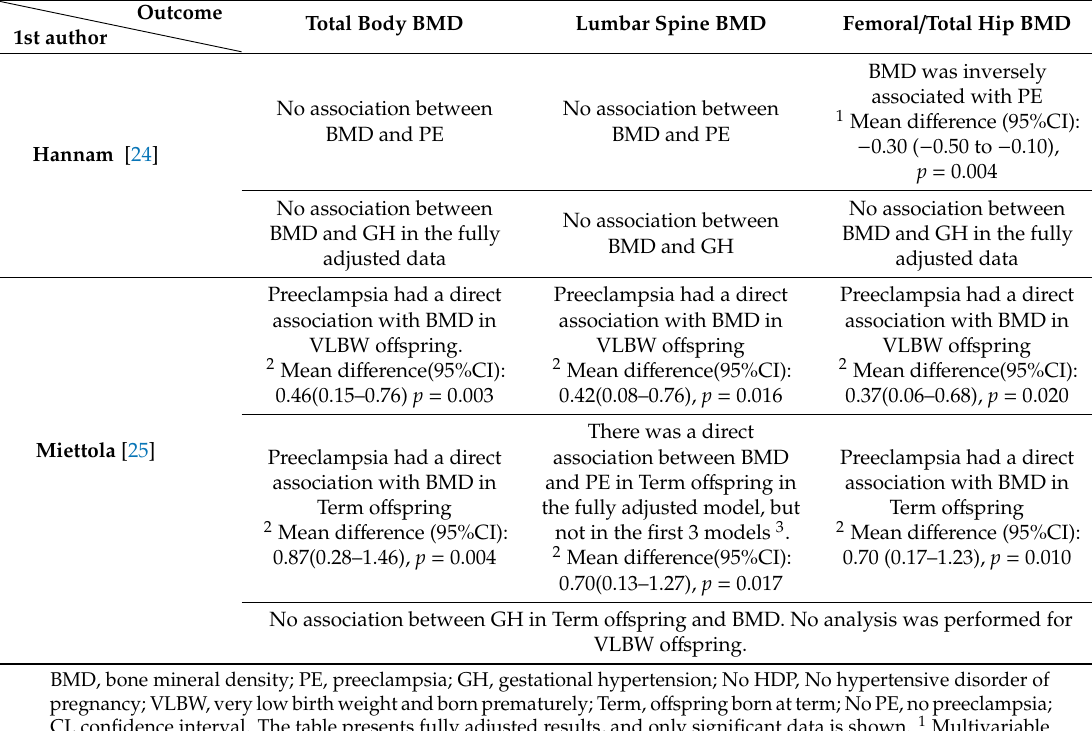
Table 4. Association between maternal preeclampsia and gestational hypertension with the o ff spring bone mineral density (BMD) in the total body, spine, and